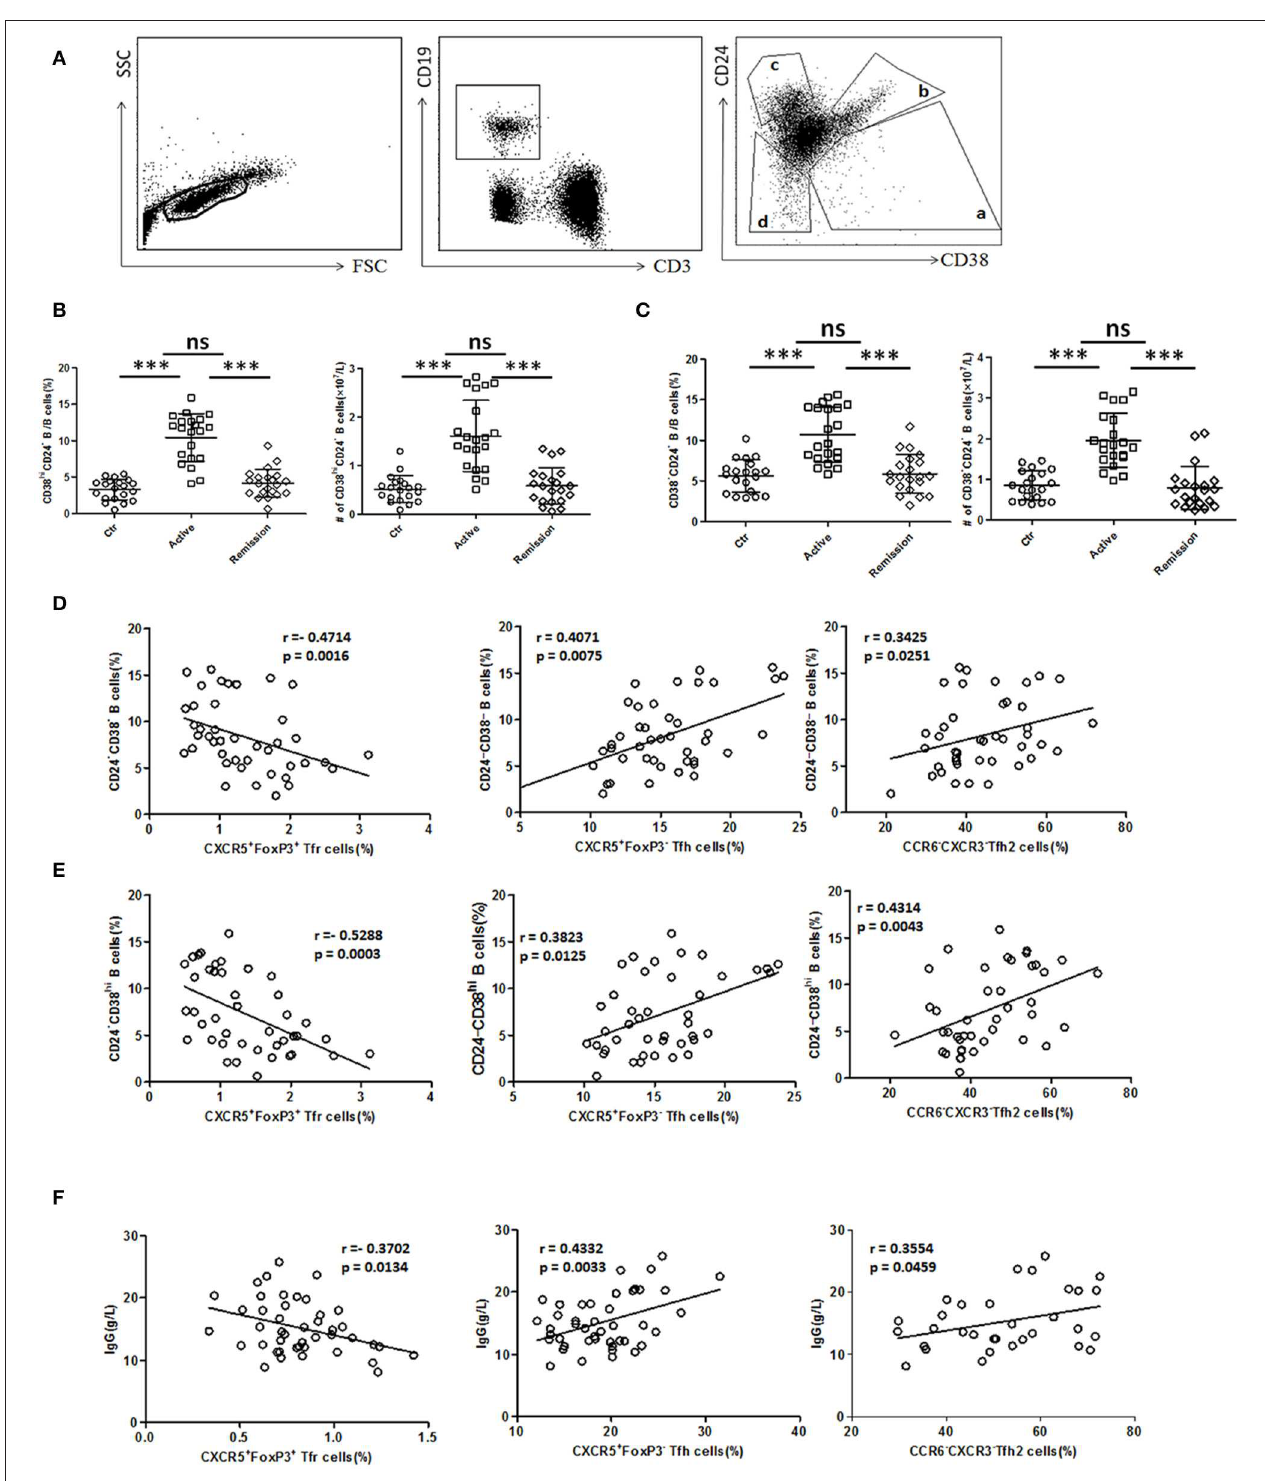
FIGURE 4 | B cell subset and serum IgG analysis and their relationship with TFR, TFH, and TFH2. (A) Peripheral blood from active UC patients ( n = 21), stable remission UC patients ( n = 21), and HC ( n = 20) were collected. CD24 and CD38 expression classifies circulating B cells into primarily memory B cells (CD19 + CD38 − CD24 high ), plasmablasts (CD19 + CD38 high CD24 − ), transitional (CD19 + CD38 high CD24 high ), and new memory (CD19 + CD24 − CD38 − ) B cell